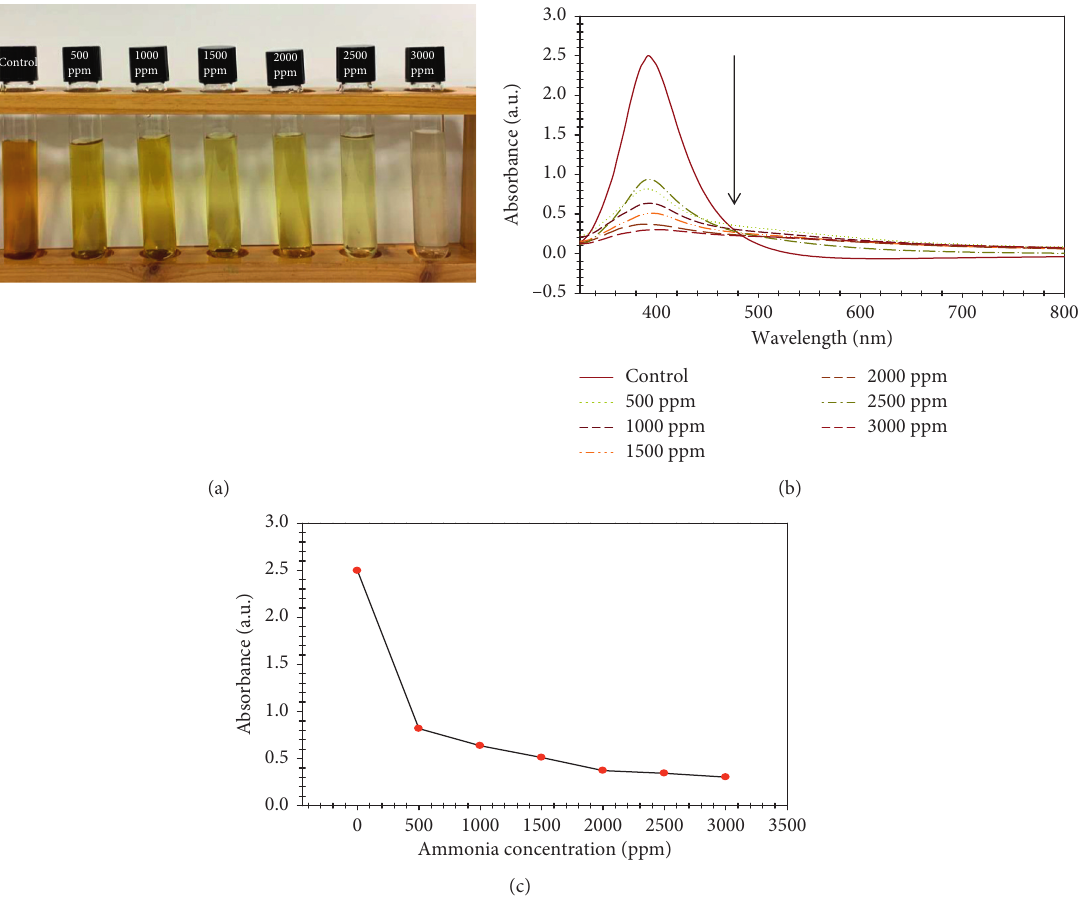
Figure 3: The effect of ammonia on the green fabricated silver nanoparticles; different levels of ammonia were added to the colloidal solution of Ag NPs containing a constant level of the nanoparticles (a). Change in the UV-visible spectra of silver nanoparticles as a function of different concentrations of ammonia from 0 to 3000ppm (b). Plot of absorbance versus ammonia concentration (c).